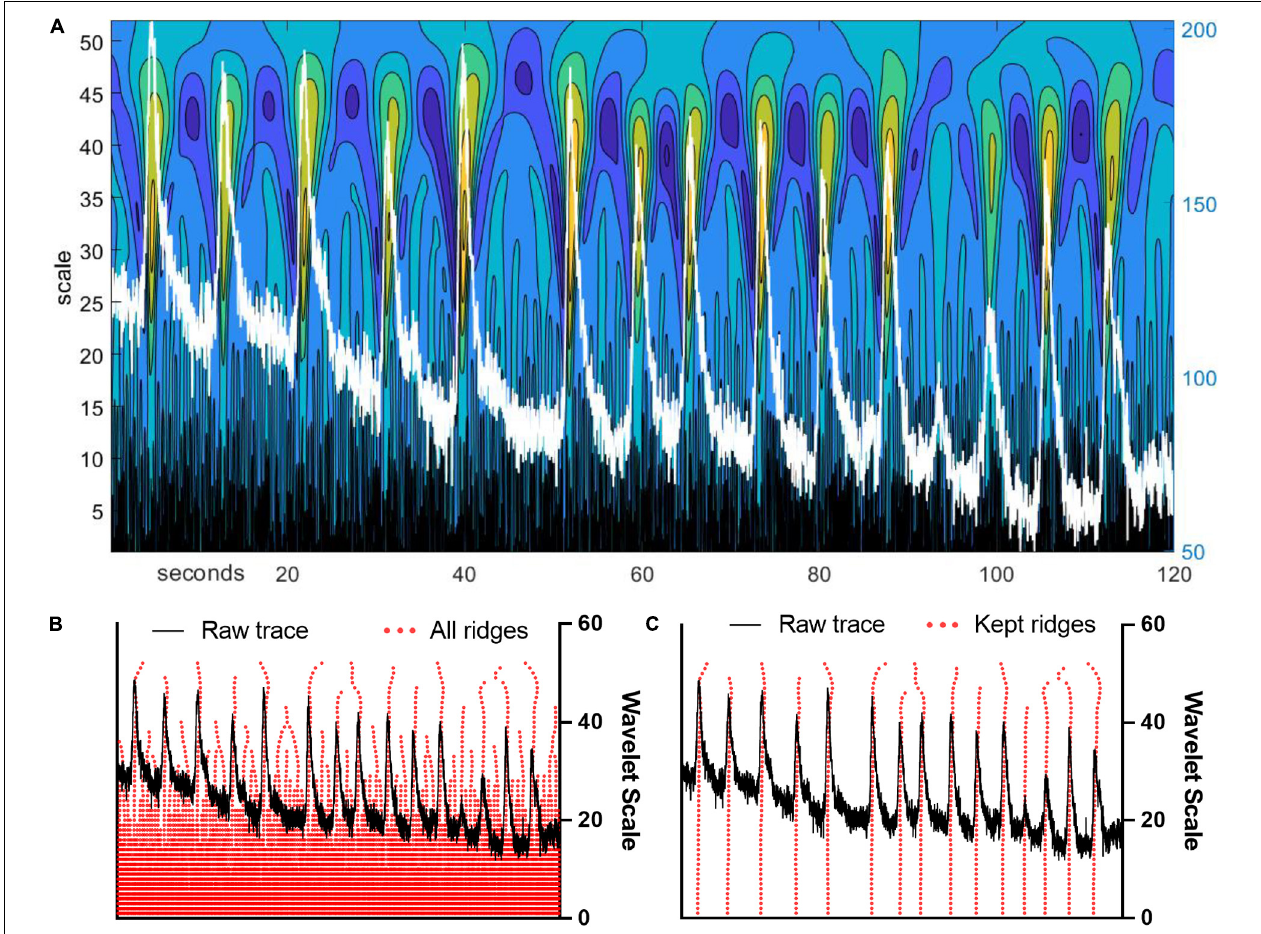
FIGURE 1 | Wavelet ridgewalking algorithm identifies neuronal events with high fidelity. (A) Continuous wavelet transform amplitude color map for an example trace overlaid in white. The left y -axis is the wavelet scale, the right y -axis is the arbitrary units of trace fluorescence amplitude, and the x -axis is the recording frame. Color scales are continuous wavelet transform (CWT) values with warmer colors representing larger CWT amplitudes. (B) Example trace with ridges generated by ridgewalking algorithm overlaid in red. (C) Example trace with significant (kept) ridges overlaid.